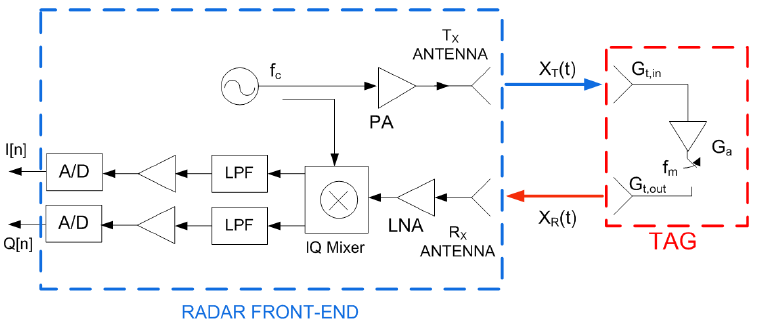
Figure 9. Schema of the mm-wave radar front-end.